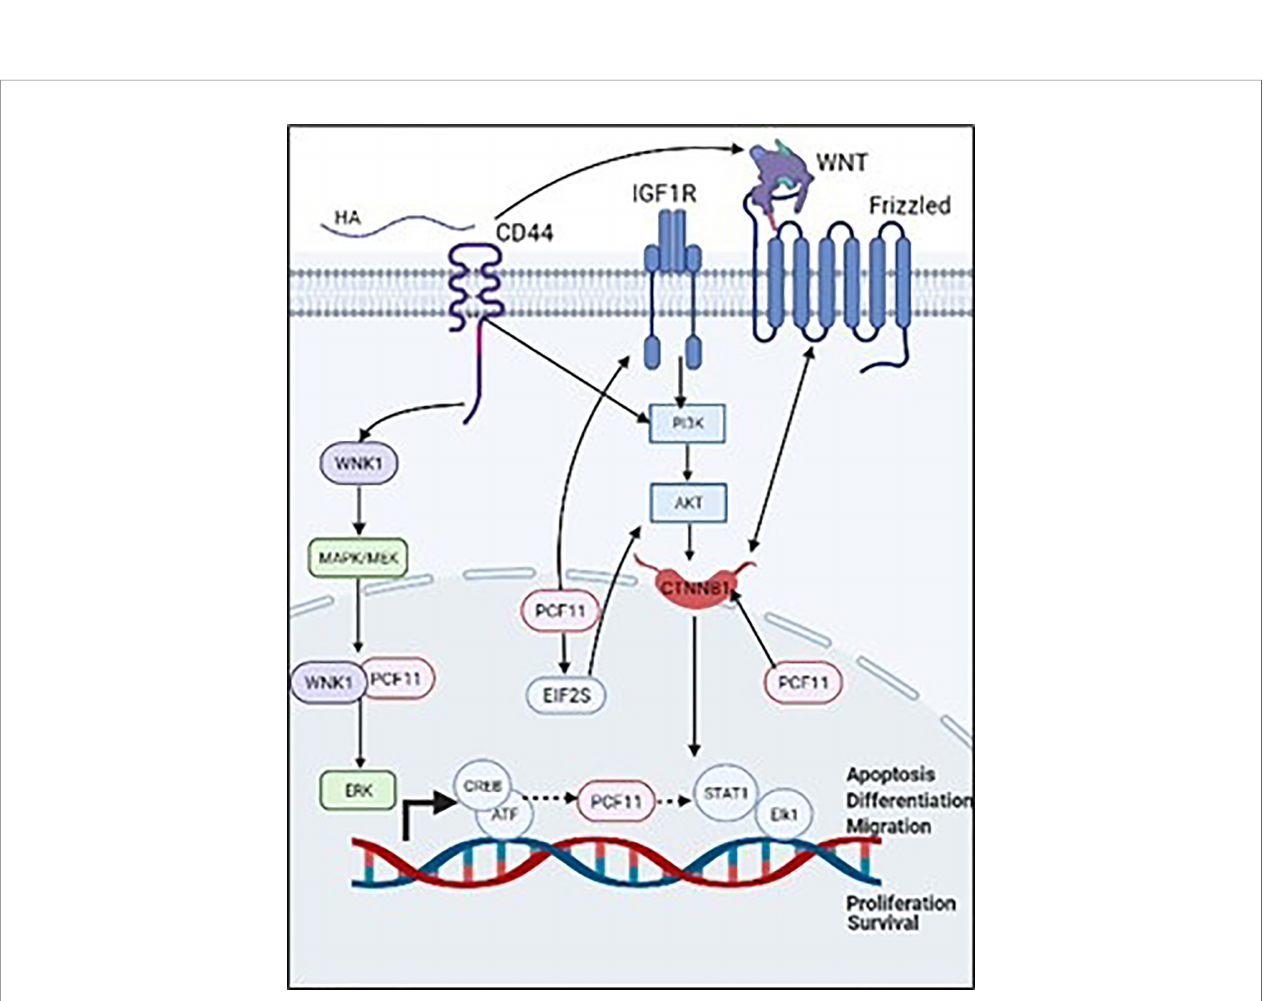
FIGURE 2 | Validated ( → ) and proposed ( ⤑ ) mechanisms that associate PCF11 to CD44/HA signaling promoted BC cell